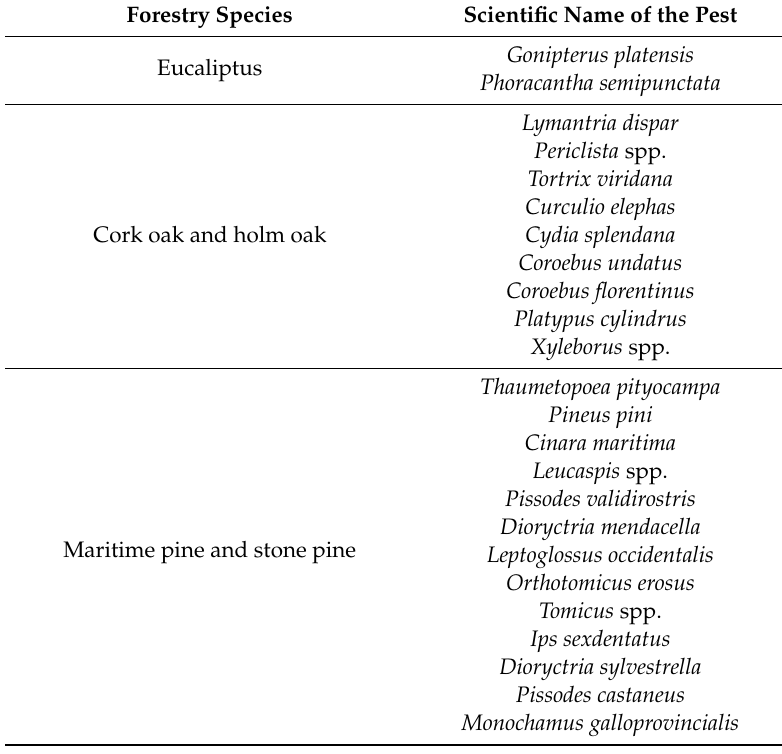
Table 1. Main pests of the forest in Portugal (adapted from